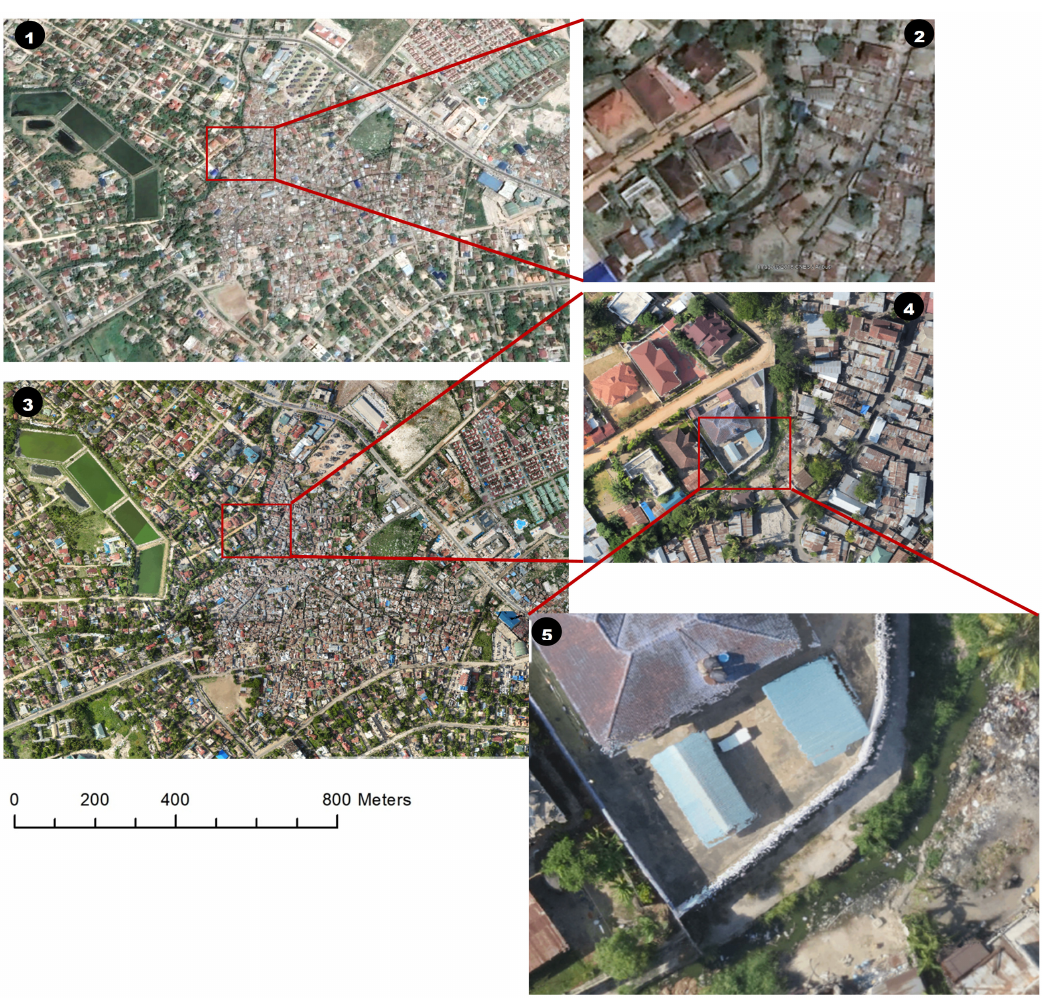
Figure 4. Comparing VHR satellite imagery with UAV images for the case of Dar es Salaam: ( 1 ) and ( 3 ) show an informal settlement surrounded by formal areas (( 1 ): VHR and ( 3 ): UAV image); ( 2 ) shows the level of detail available in VHR imagery; ( 4 , 5 ) show the level of detail available in UAV images (Image source: Google Earth and Ramani